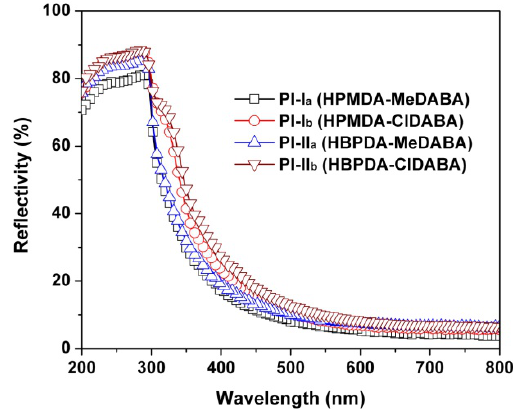
Figure 8. UV–Vis reflectivity spectra of PI films.